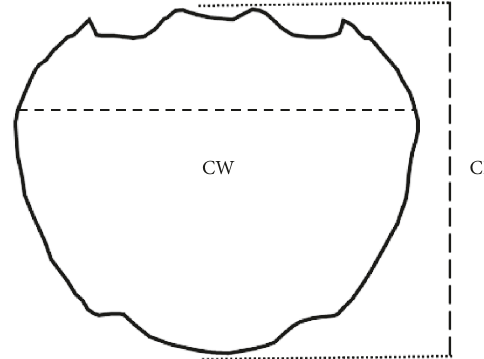
Figure 2: Position of carapace measurement in Potamon algeriense .